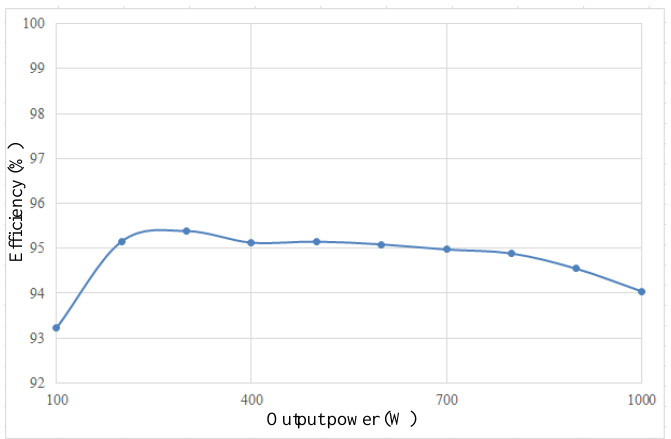
Figure 12. The measured efficiency from light load to full load.